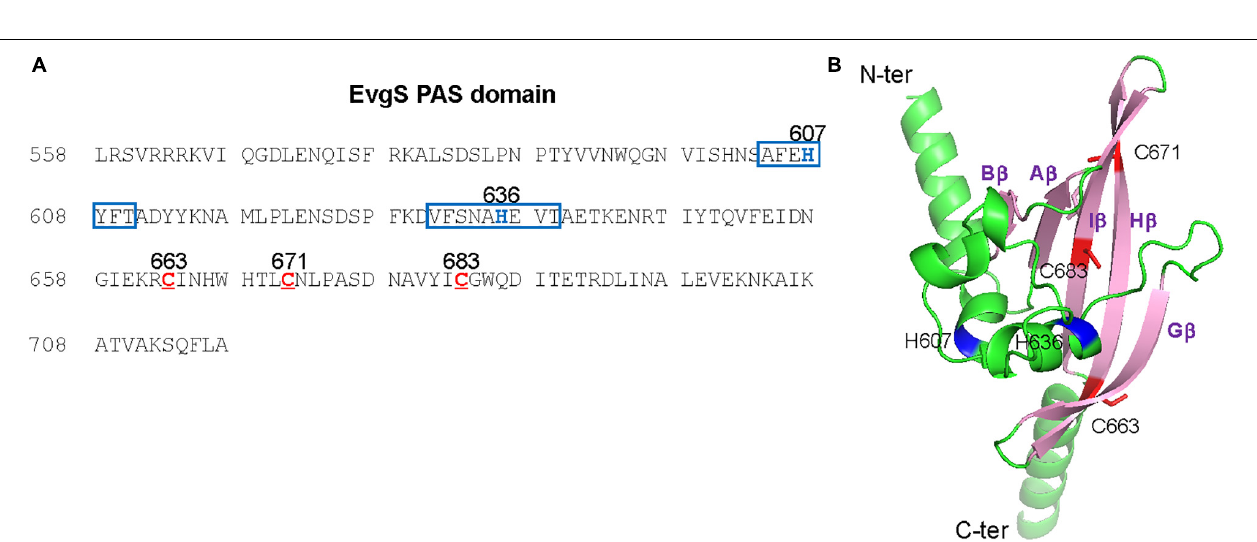
FIGURE 4 | Positions of three cysteine residues and putative quinone-binding motifs in the EvgS PAS domain. (A) The sequence of the EvgS PAS domain is shown with three cysteines (C663, C671, and C683) depicted in red. In addition, the putative quinone-binding motifs are boxed in blue with central histidine residues (H607 and H636) depicted in blue. (B) A homology model of the EvgS PAS domain was created by the SWISS-MODEL homology-modeling server (https://swissmodel.expasy.org, Waterhouse et al., 2018) using the PAS domain of BvgS of Bordetella pertussis (PDB entry ID: 6ZJ8) as a template. The model is presented by a cartoon model with C663, C671 in H β strand, and C683 in I β strand depicted in red. Side chains of C663, C671, and C683 are shown with sticks. The central histidine residues, H607 and H636, located on two Q-helices, are depicted in blue.